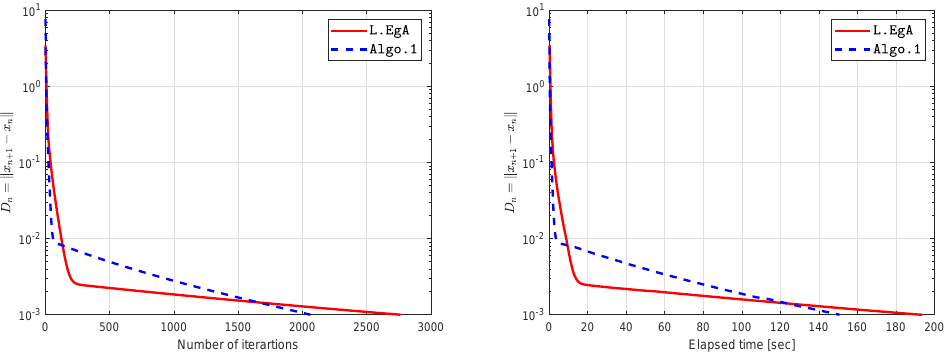
Figure 2. Example 1 while tolerance is